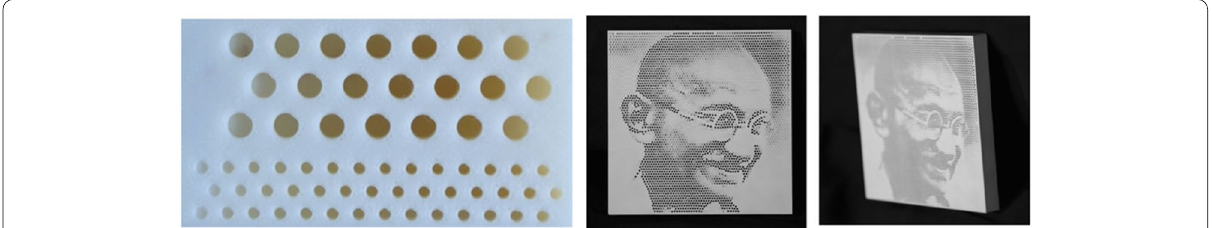
Fig. 9 On the left is a close‑up of the 3D printing result of Alexa and Matusik [16]. Increasing the depth of the hole causes it to appear darker. They use this fact to create self‑shadowing